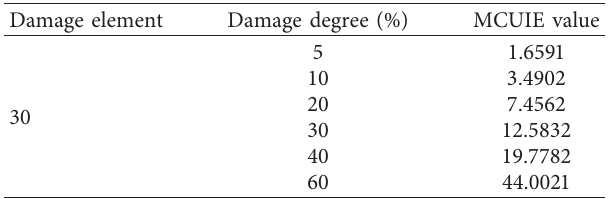
Table 3: MCUIE value of Single damage with different damage degrees. Damage